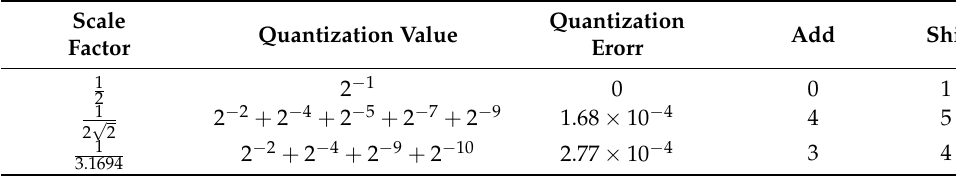
Table 1. Scale factors used in the work of Sun et al. [29] and in this work.